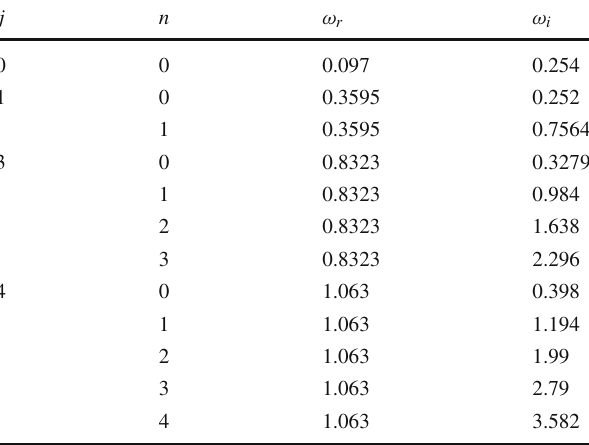
Table 1 The values of the quasinormal frequencies in the (small) non- Schwarzschild geometry for the values of parameters r + = 0 . 5 , M = 0 . 55 ,α = 0 . 5